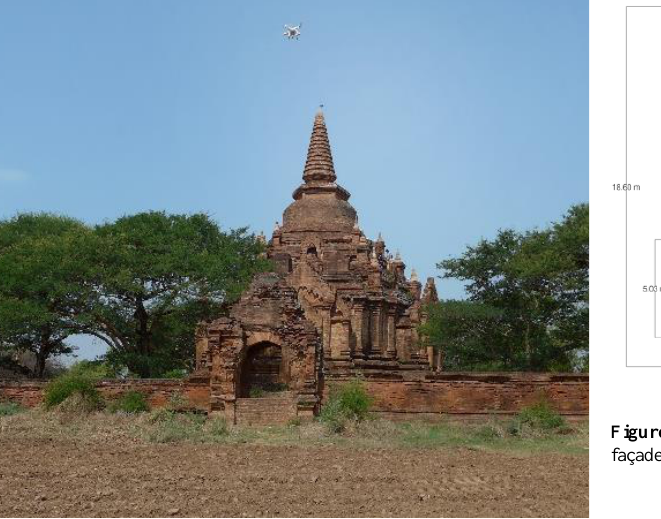
Figure 6 Eim-Ya-Kyaung-Nga-Myet-Hna temple with drone These temples were chosen to define a flexible methodology that could be applied to the heterogeneous Bagan monuments.